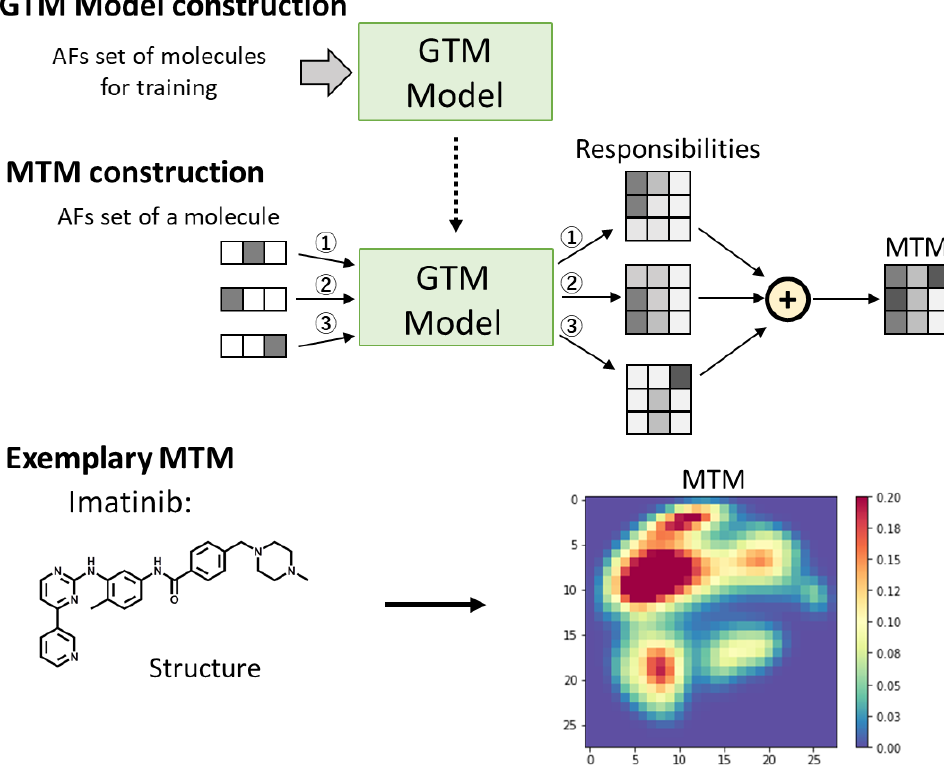
Figure 2. The workflow of MTM generation. GTM model is constructed using the Atomic Features (AFs) set of molecules for training. The GTM model is used for generating MTM from the AFs set of a molecule. The MTM of imatinib is shown as an exemplary MTM.